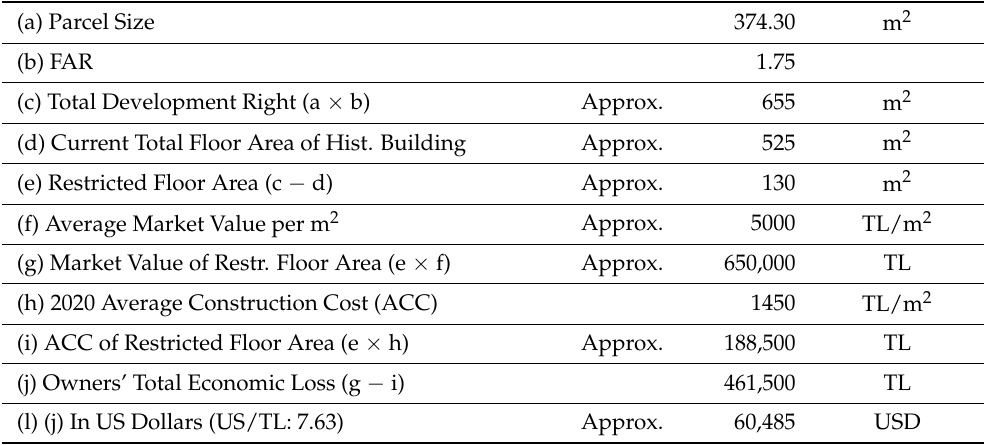
Table 3. Overview of the calculations of Example